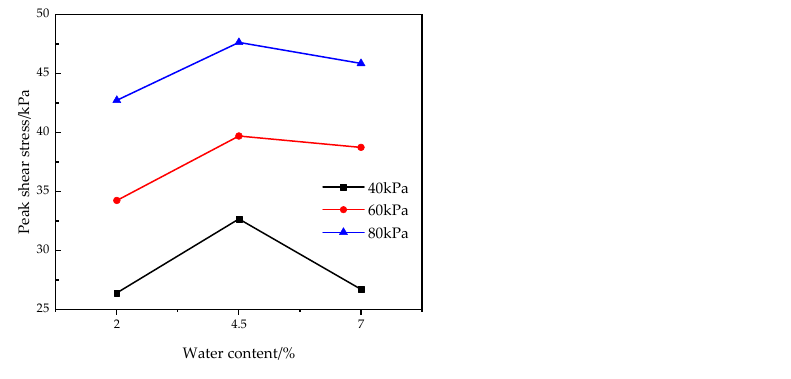
Figure 10. The influence of water content on the peak shear stress of the reinforced soil interface under the nonfreezing state (0 °C).